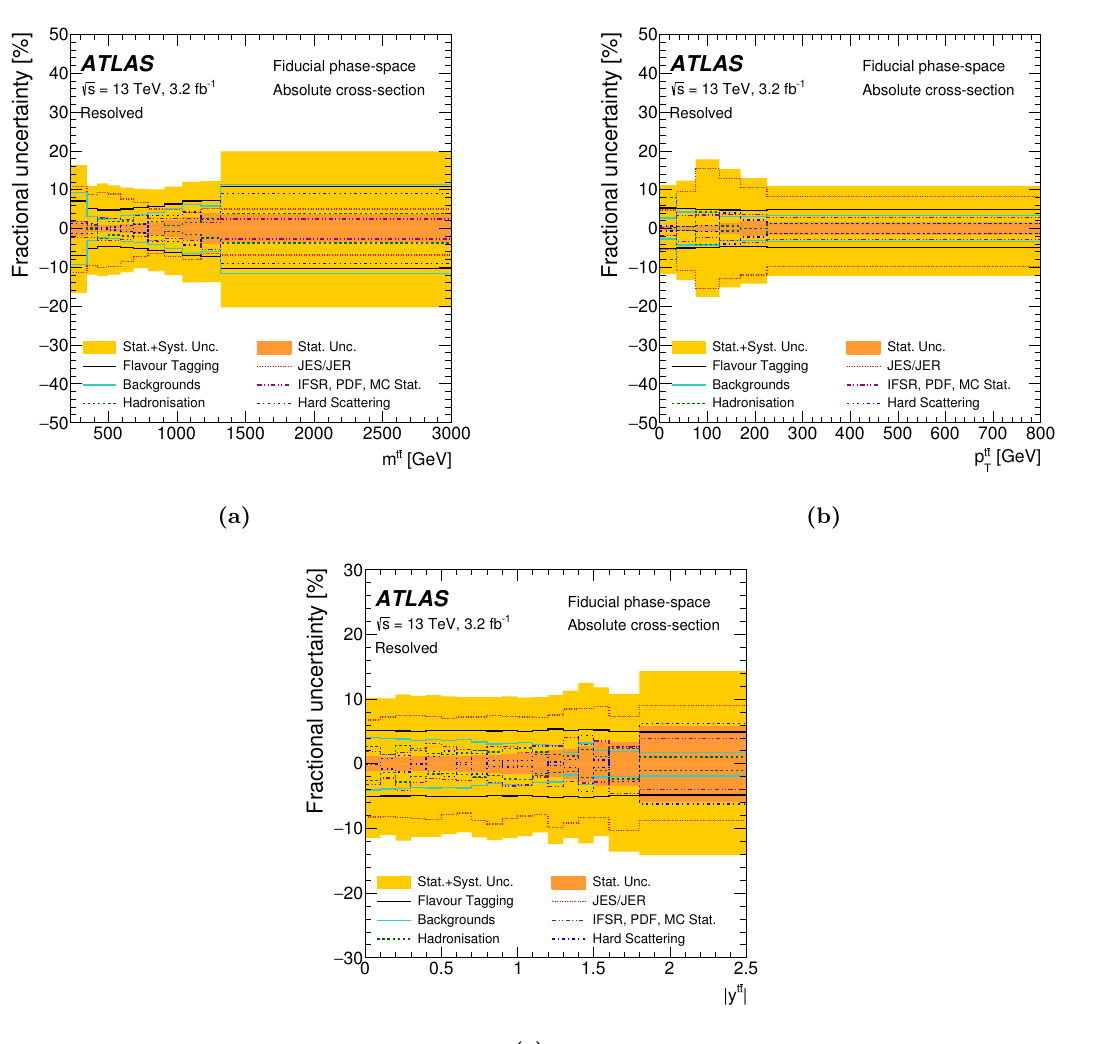
Figure 12. Uncertainties in the (cid:12)ducial phase-space di(cid:11)erential cross-sections as a function of the (a) invariant mass ( m t (cid:22) t ), (b) transverse momentum ( p t (cid:22) t (cid:12) (cid:22) t (cid:12) ( (cid:12) y t (cid:12) ) of the t (cid:22) t system in the resolved topology. The yellow bands indicate the total uncertainty of the data in each bin. The Powheg + Pythia6 generator with h damp = m t and the CT10 PDF is used as the nominal prediction to correct for detector